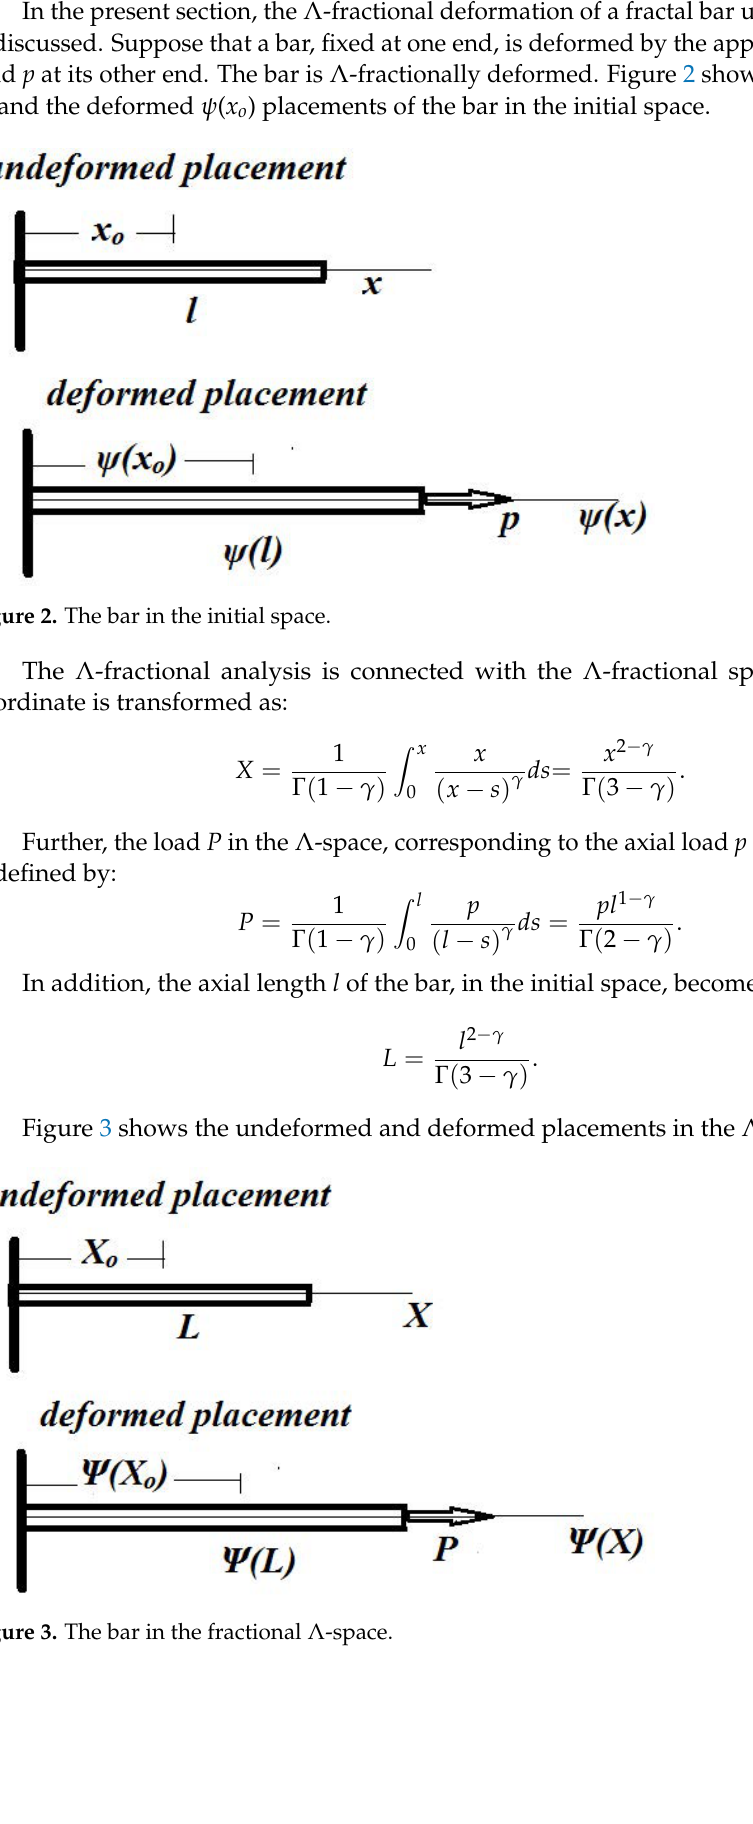
Figure 3. The bar in the fractional Λ -space. Moreover, the constant elastic modulus E in the initial space is transferred in the Λ -fractional space as non-constant E Λ along the x -axis. Indeed: 𝐸 (cid:3064) =